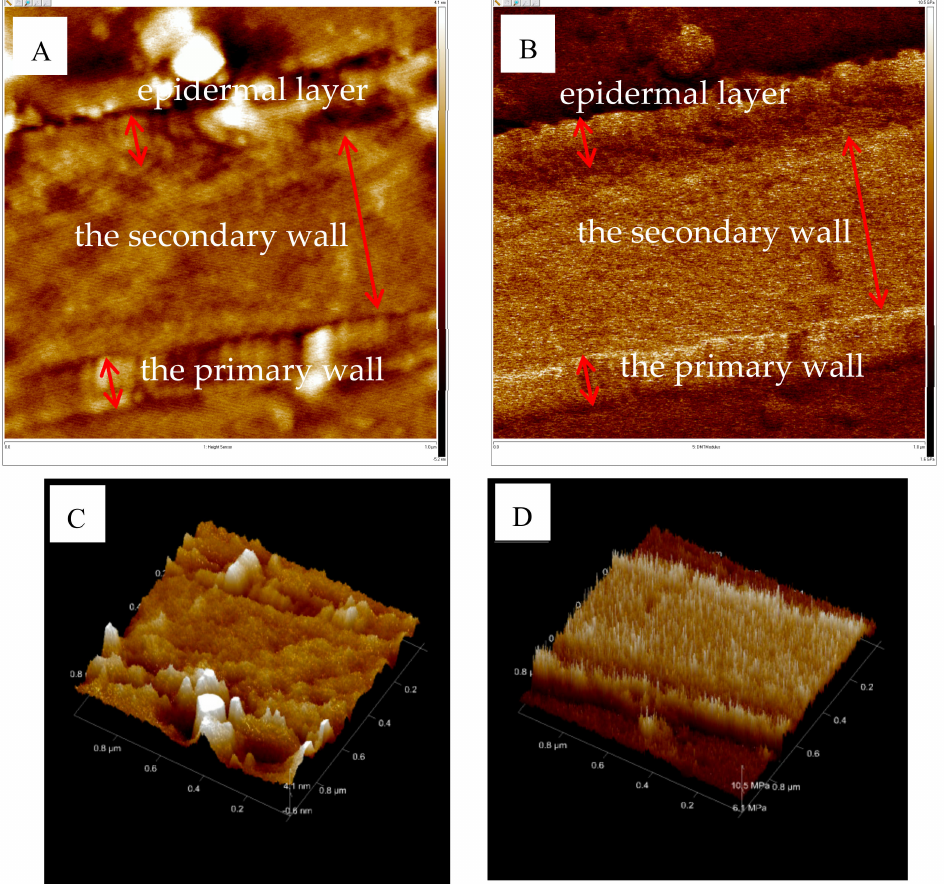
Figure 9. AFM observation of the cell wall structure of a poplar catkin fiber (cross-section; ( A ) height image; ( B ) modulus image; ( C ) 3D height image; ( D ) 3D modulus